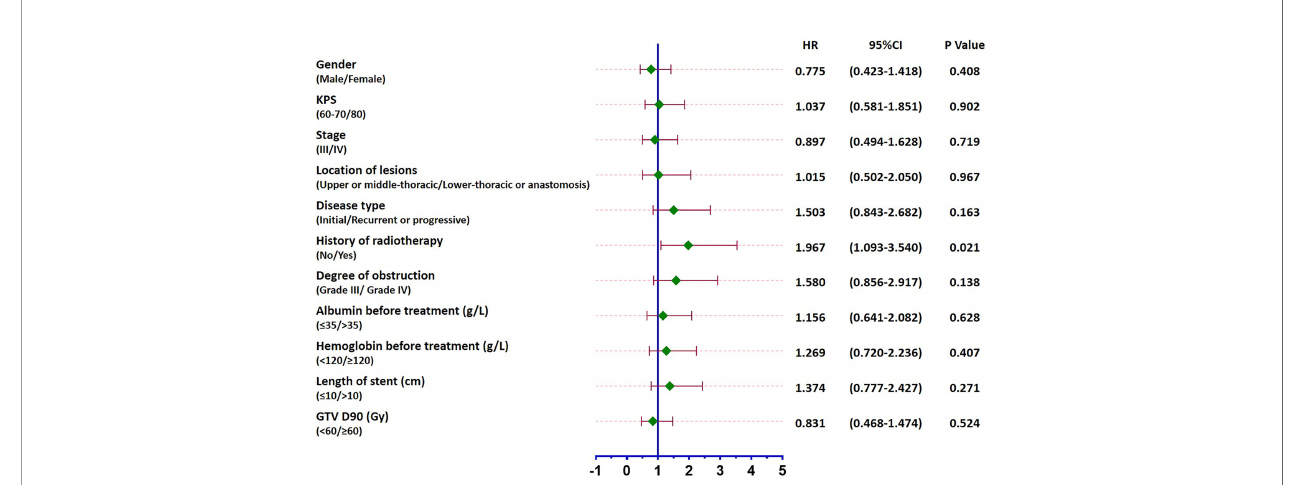
FIGURE 5 | Forest plot of factors affecting patients ’ survival. While a previous history of radiotherapy led to the prognosis of patients (P = 0.021), no other in fl uencing factors were identi fi ed (P >